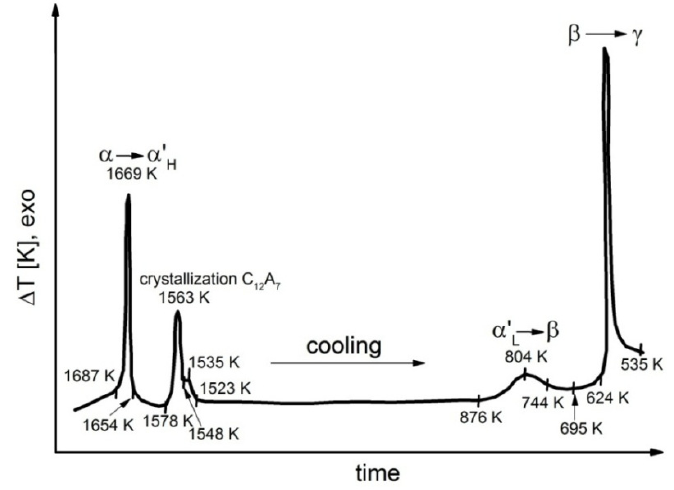
Figure 7. Thermogram recorded for sample 4 during the cooling process.